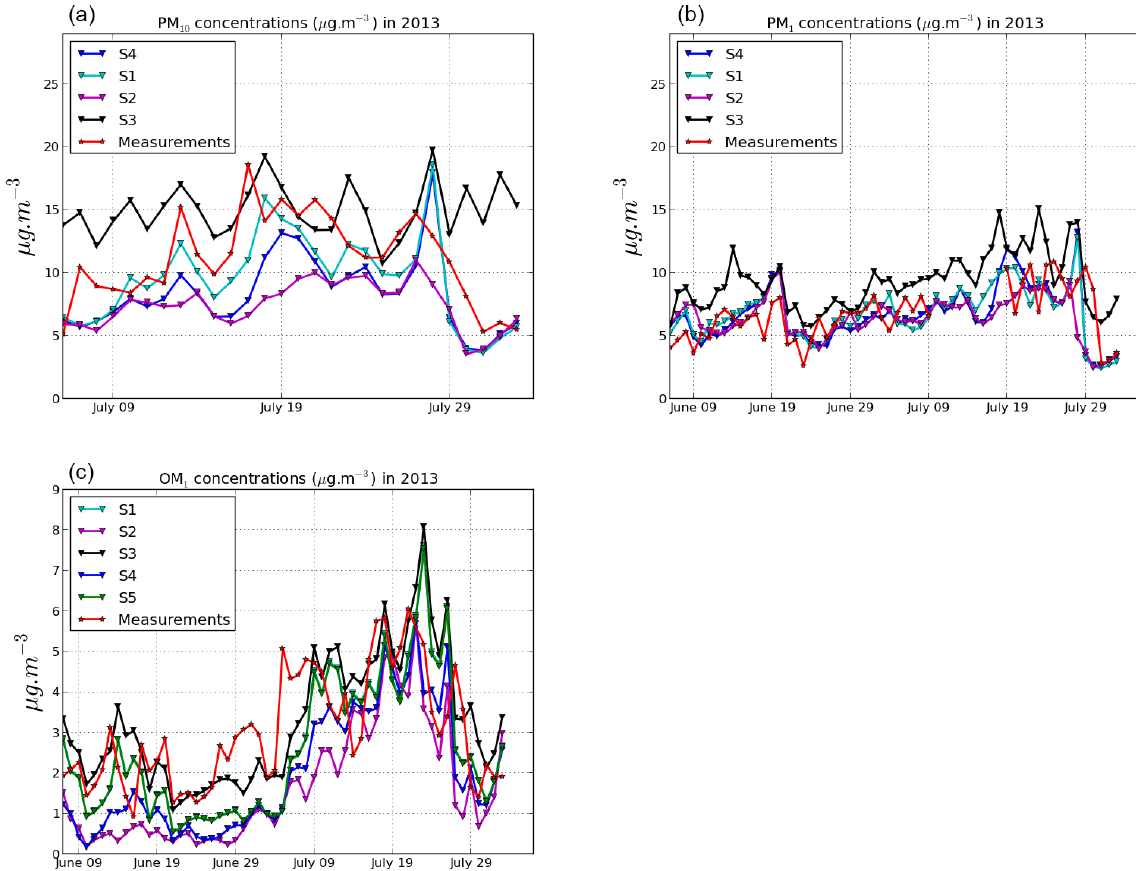
Figure C1. Comparisons of PM 10 (a) , PM 1 (b) and OM PM